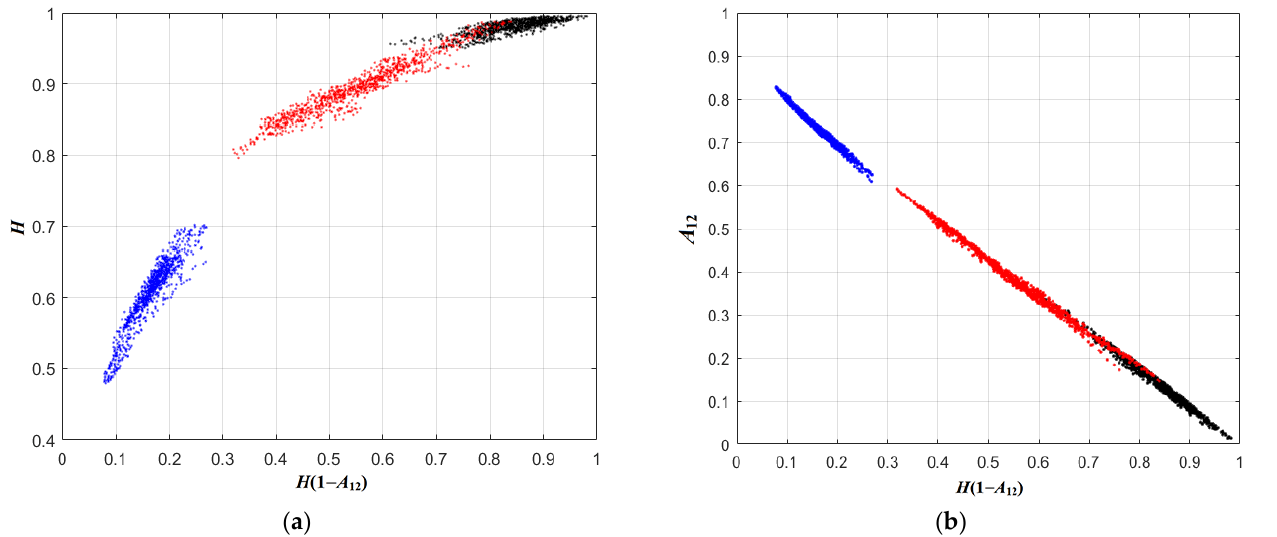
Figure 5. Scatter plots of combination parameter versus corresponding single-component parameters: ( a ) H (1 − A 12 ) vs. H ; ( b ) H (1 − A 12 ) vs. A 12